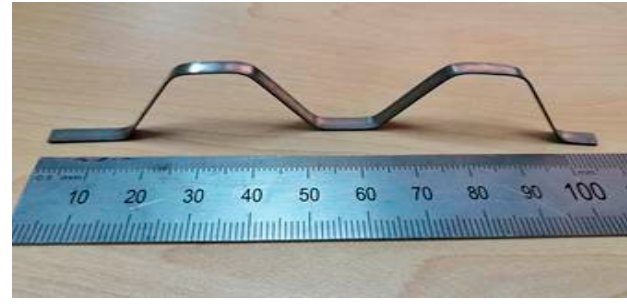
Figure 3. Monomer of NiTi SMA bracket.